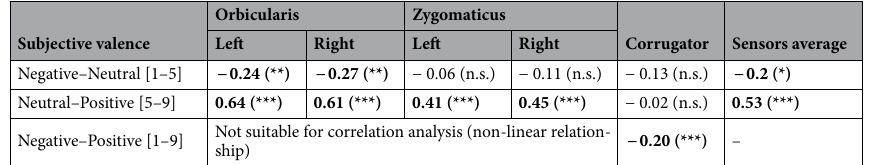
Table 2. Pearson’s correlation coefficient (and corresponding statistical significance in brackets) for the relation between subjective valence and sEMG amplitudes. The subjective valence is represented in three variations: Negative to Neutral [1–5], Neutral to Positive [5–9], and Negative to Positive [1–9]. Statistical significance annotations: * if p ∈ [.05, 10 −2 ); ** if p ∈ [10 −2 , 10 −3 ); *** if p ∈ [10 −3 , 10 −4 ); and **** if p ≥ 10 −4 . Significant values are in